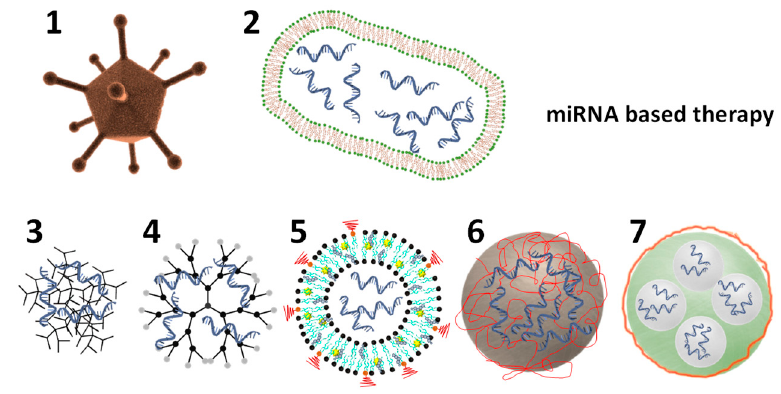
Figure 3. Schematic representation of di ff erent nanovectors loaded with miRNA-based therapies. ( 1 & 2 ) depict an adenovirus and an EDV TM nanocell. ( 3 ) Depicts a nanovector made of a positively charge polymer and negatively charged miRNA-based therapy. ( 4 ) Depicts a dendrimer. ( 5 ) Depicts a multifunctional liposome, loaded in its interior with miRNAs and functionalized with PEG (in red) on its surface and a contrast agent (yellow star) within the lipidic bilayer. ( 6 ) Depicts a solid nanoparticle coated with a positively charged polymer (in red) and the miRNA-based therapy via self-assembly. ( 7 ) Depicts a porous solid particle which encapsulates the miRNA-based therapy within its pores and it is coated to seal the pores. Therapeutic miRNA is depicted in blue and polymeric coatings in red.